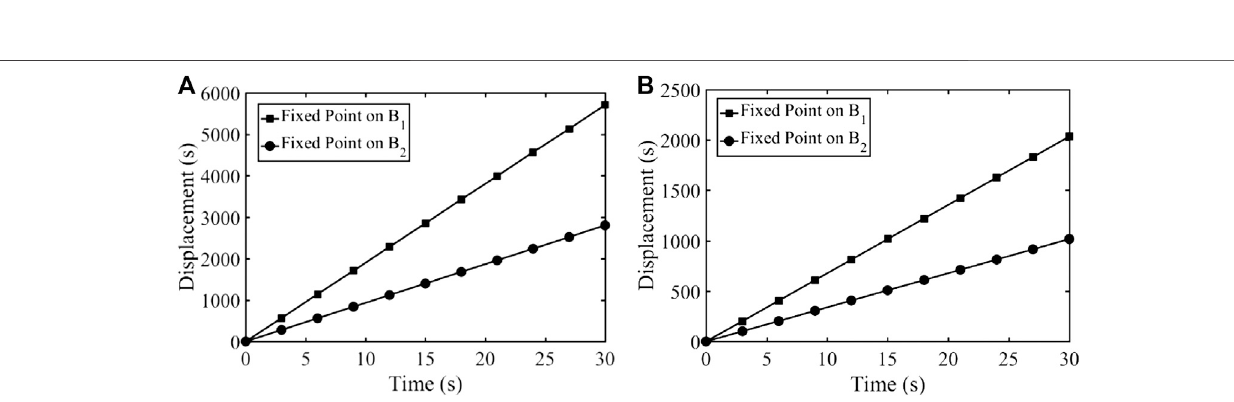
FIGURE 14 | Snapshots of simulations with different adjustable parameters (A . fi xed point on B1, α =0 ° , B . fi xed point on B2, α =0 ° , C . fi xed point on B1, α =20 ° , D. fi xed point on B2, α =20 ° ).